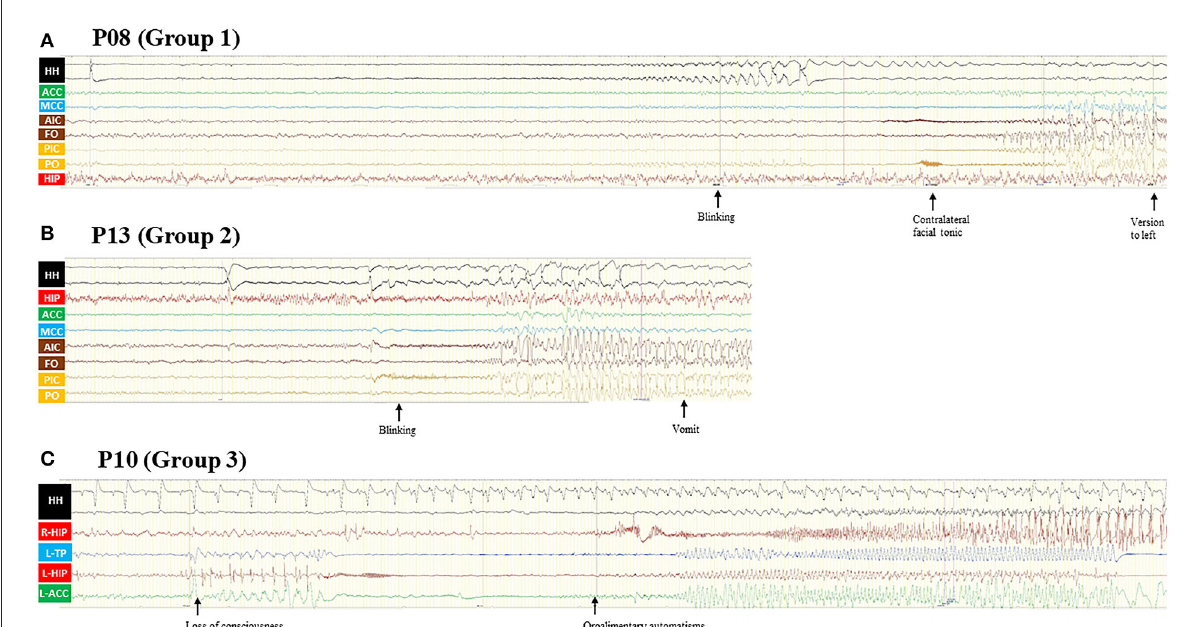
FIGURE3 (A) Patient 8 was a 12-year-old boy with normal cognitive and physiological development. GS started at the age of 9 years and disappeared after HH-resection 3 years ago, and FBTCS relapsed. Semiology includes eye blinking and a contralateral facial tonic seizure and finally evolving into a bilateral asymmetric tonic seizure. The ictal discharge first appeared in HH and then propagated to the INS, insular operculum, and MCC. (B) Patient 13 was a 15-year-old boy with a seizure duration of 5 years. The only seizure type of this patient was eye blinking with awareness, accompanied by flush and vomit sometimes. SEEG recording showed HH onset and then propagated to the INS, insular operculum, and MCC. (C) Patient 10 was a 22-year-old male with normal cognitive and physiological development. Seizure presented at the age of 21 years with typical unconscious oroalimentary and hand automatism. SEEG recording showed an onset from the left HIP and temporal pole and then propagated to the ipsilateral ACC, contralateral HIP, and HH. Even though the HH attachment of HH has rhythm changed, the interictal discharge of HH remained nearly the same. GS, gelastic seizures; FBTCS, focal to bilateral tonic-clonic seizures; SEEG, stereo-electroencephalography; HH, hypothalamic hamartoma; ACC, anterior cingulate cortex; MCC, middle cingulate cortex; AIC, anterior insular cortex; PIC, posterior insular cortex; FO, frontal operculum; PO, parietal operculum; HIP, hippocampus; TP, temporal pole; L, left; R,